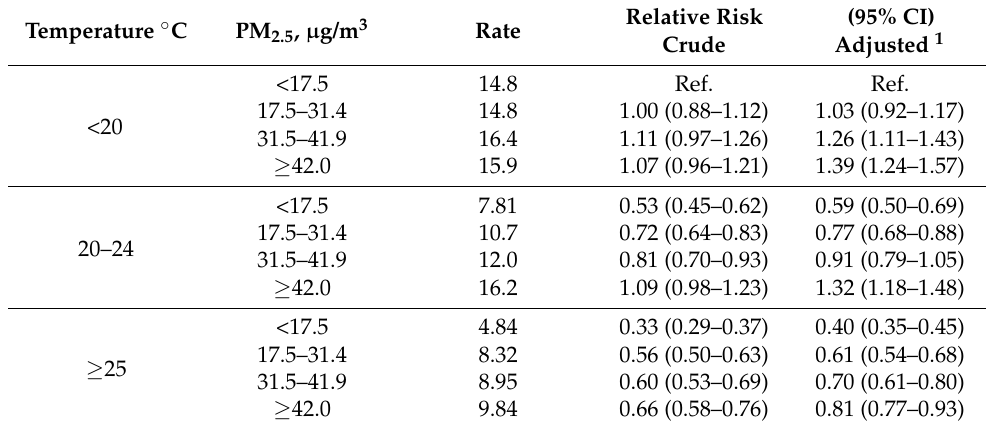
Table 3. Childhood rotavirus infection rate per 100 days by average daily PM 2.5 level within each average temperature level and Poisson regression analysis estimated relative risk of the infection. Relative Risk (95% CI) Temperature ◦ C PM 2.5 , µ g/m 3 Rate Crude Adjusted 1 <17.5 14.8 Ref. <20